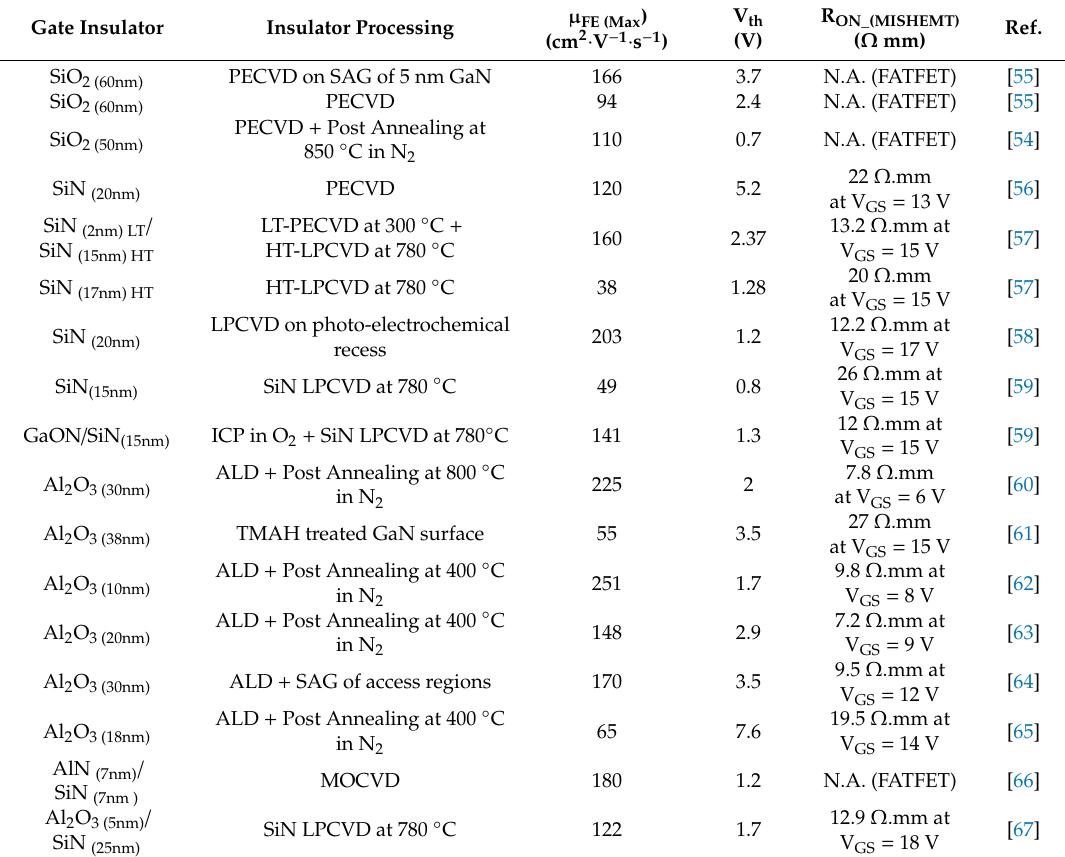
Table 3. Survey of literature data on normally-o ff recessed gate hybrid GaN MISHEMTs, employing di ff erent gate